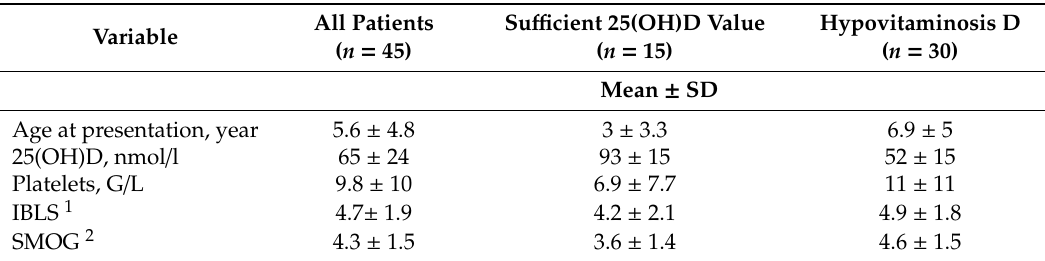
Table 1. Distribution of age, 25(OH)D, platelet count, IBLS and SMOG score at presentation of ITP ( n = 45). Variable